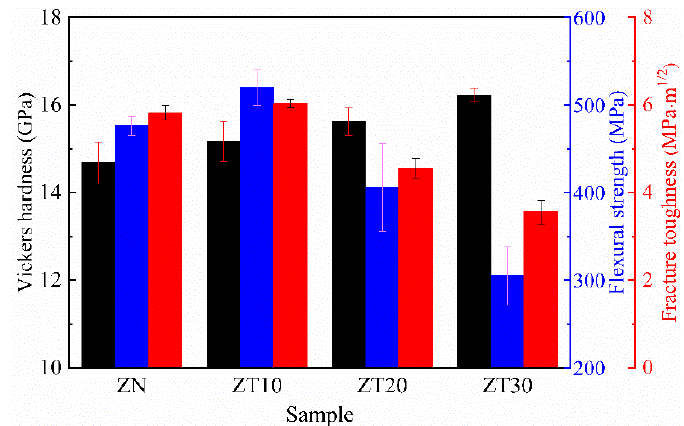
Figure 8. The mechanical properties of the sintered samples.